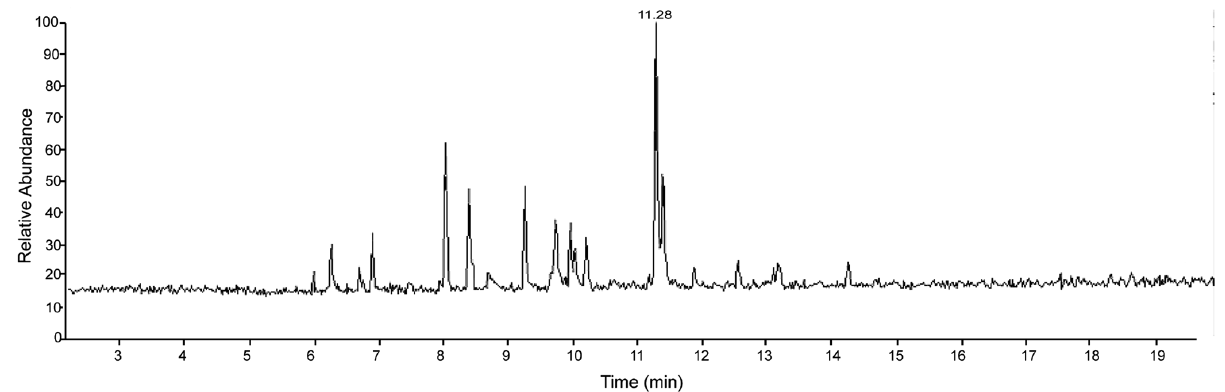
Fig. 2 Total ion chromatogram of the sample